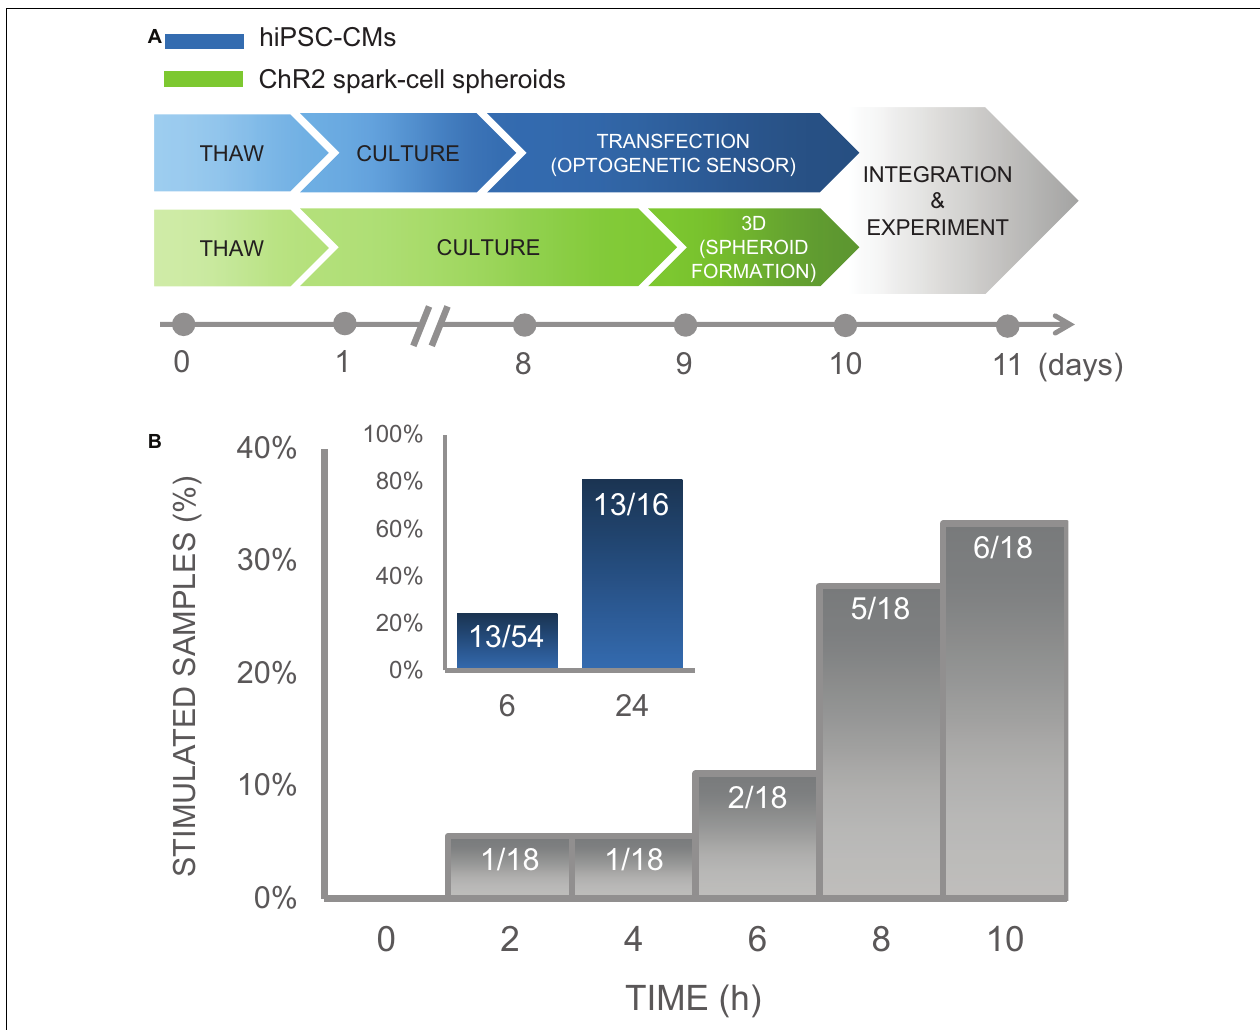
FIGURE 7 | Time course of integration of spark-cell clusters with human iPS-CM monolayers for pacing capture. (A) Experimental preparation timeline including separate treatment of cell lines (hiPSC-CM in blue and ChR2 293Ts in green) before acute functional studies. (B) For an early integration study, 18 samples were tested and the percentage of those samples from which we observed full pacing capture was plotted every 2 h. We observed an increase in the number of optical pacing responders over 10 h. The inset (blue), represents the combined results over multiple cell cultures, summarized as a percent of samples that responded to optical pacing at 6 h ( n = 54) and at 24 ( n = 16) after spheroids were seeded onto hiPSC-CM syncytia.